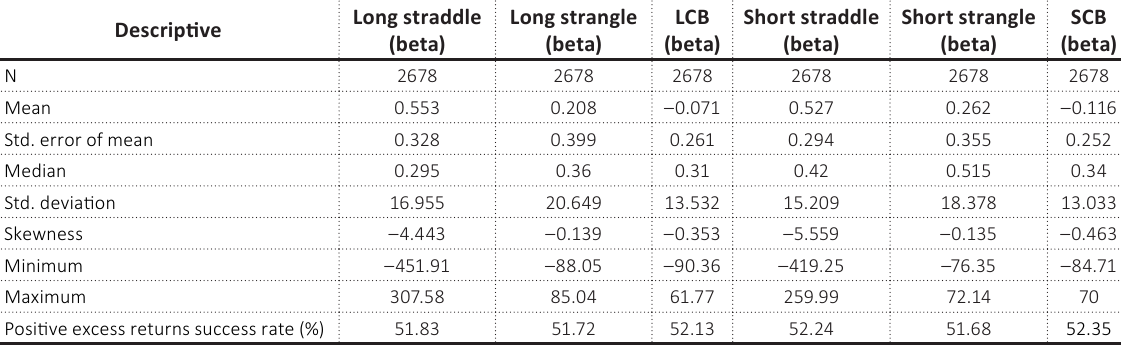
Table 8. Excess returns to beta in neutral market